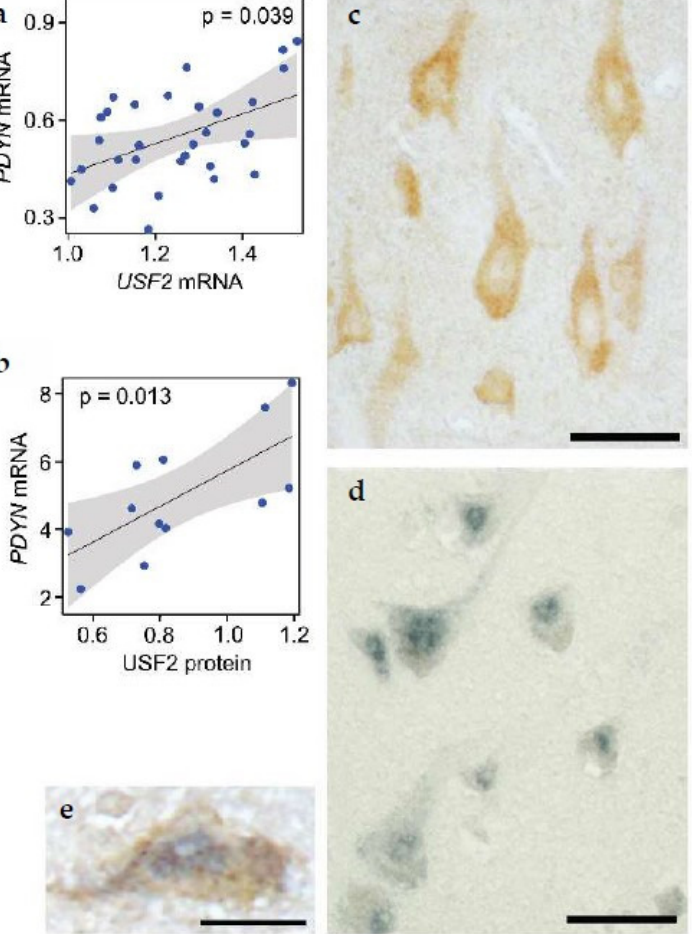
Figure 7 . Correlation of USF2 and PDYN ( a , b ), and their co-localization ( c – e ) in the human dlPFC. ( a , b ) The estimated effect with 95% confidence interval. Immunoreactivity of ( c ) PDYN, and ( d ) USF2 in the cytoplasm and nuclei of the layer V neurons, respectively. ( e ) Double labeling of PDYN and USF2 in the same neuron. Scale bars, 50 μ m ( c , d ); and 25 μ m ( e ). Modified from [79].